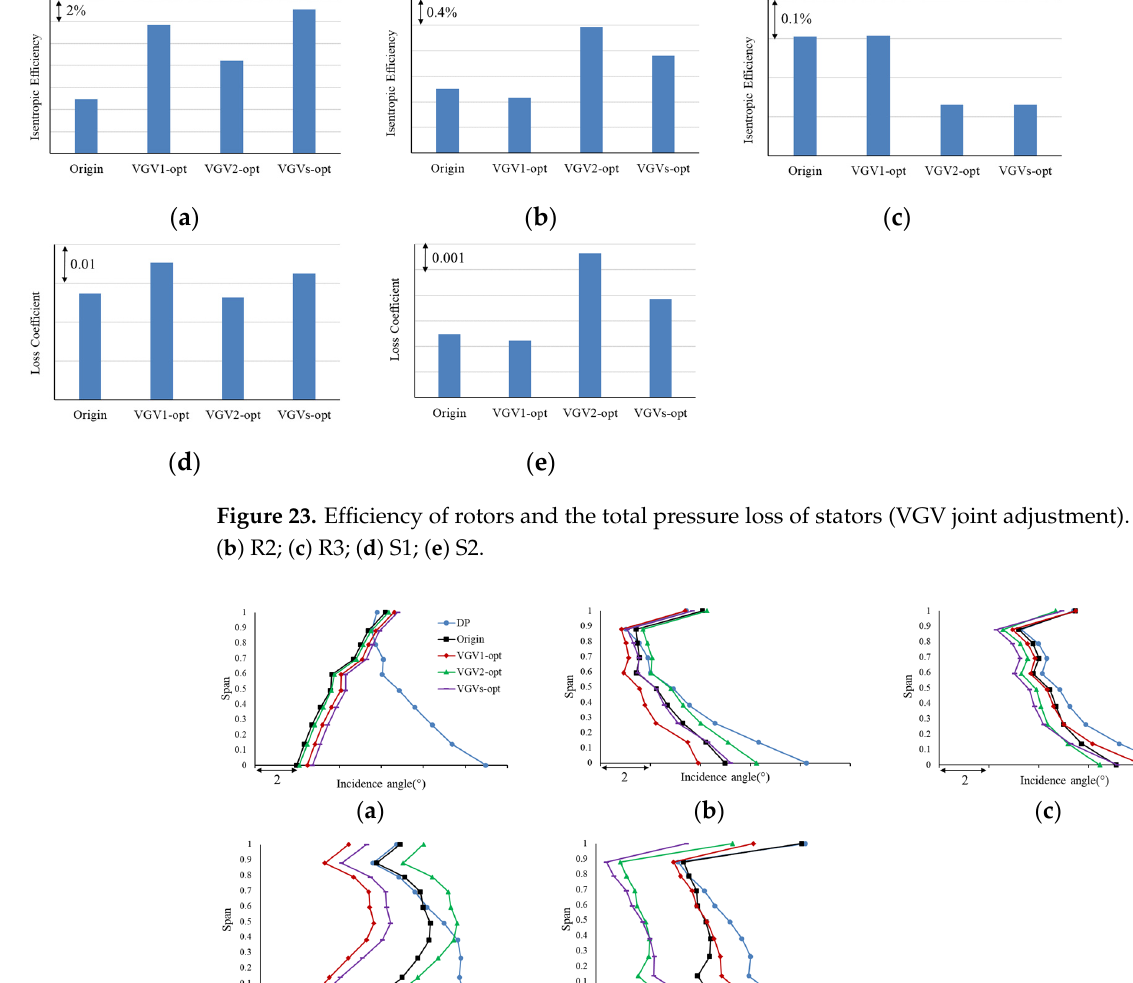
Figure 23. Efficiency of rotors and the total pressure loss of stators (VGV joint adjustment). ( a ) R1; ( b ) R2; ( c ) R3; ( d ) S1; ( e ) S2.